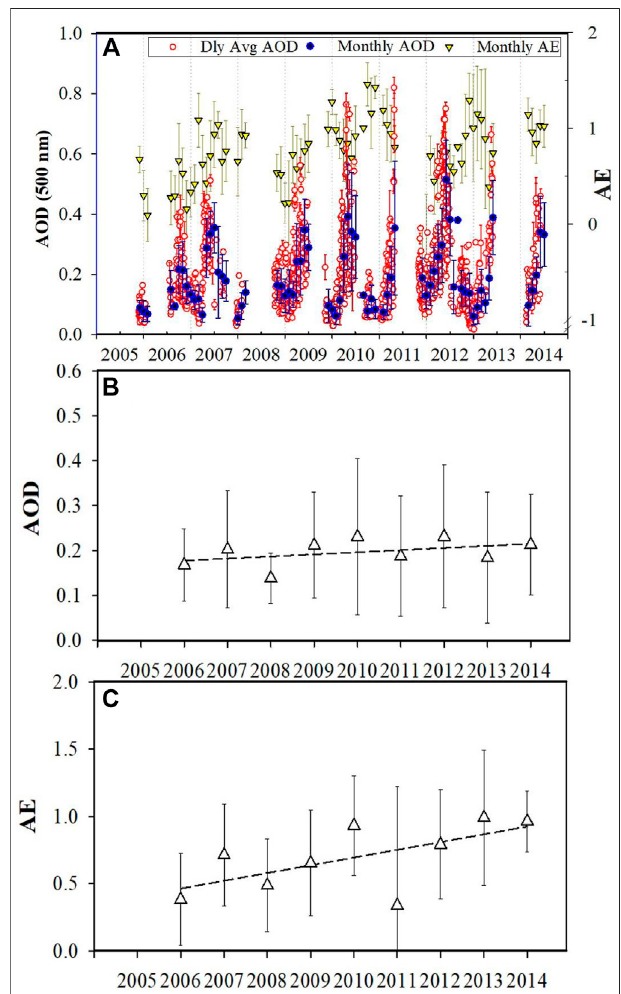
FIGURE 6 | (A) Seasonal variation in daily and monthly mean aerosol optical depth (AOD) at 500 nm wavelength and aerosol Angstrom